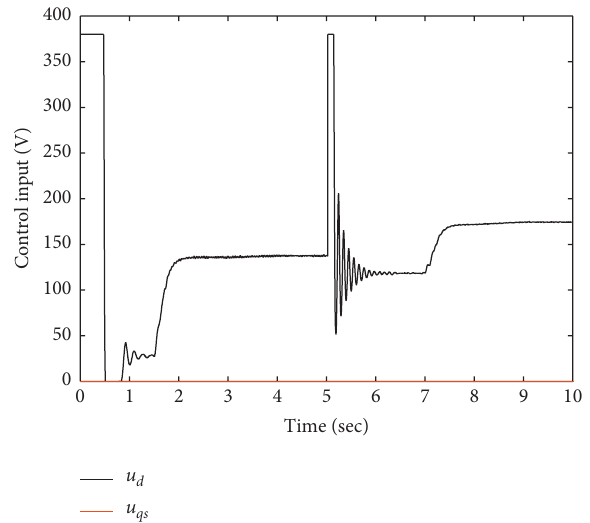
Figure 15: Time profile of control input (noisy